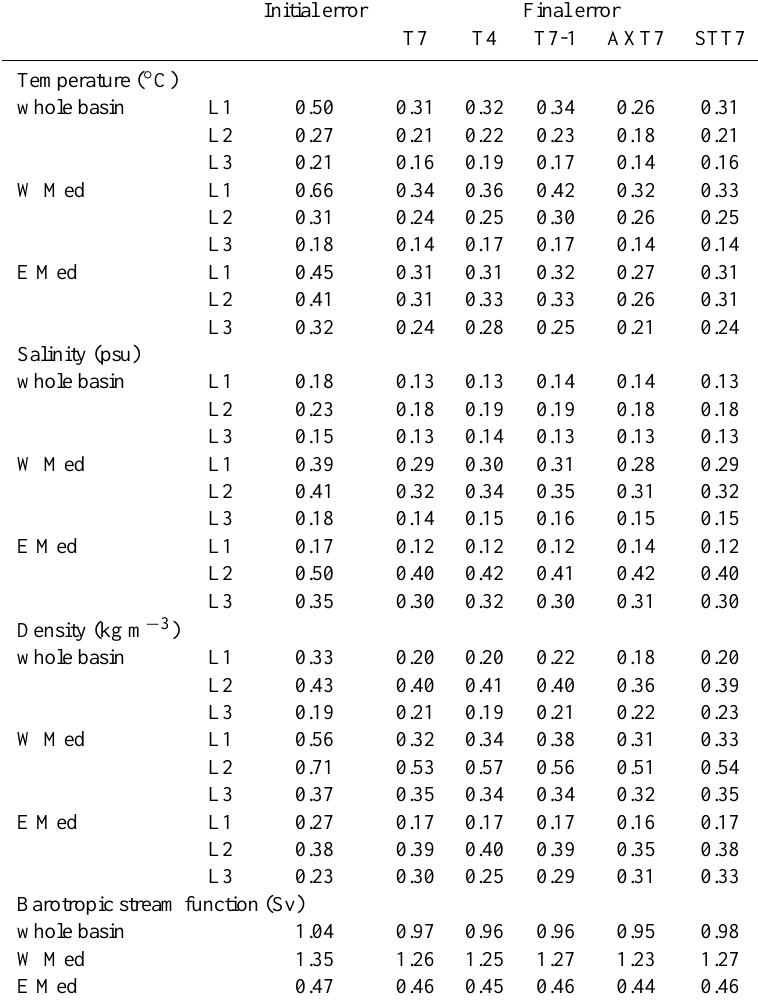
Table 5. Summer OSSEs: Initial and final errors in the assimilation runs relative to the control run for selected sampling strategies (T7, T4, T7-1, AXT7, STT7) arranged by parameter (temperature, salinity, density, barotropic stream function), basin (whole, western, eastern Mediterranean) and layer (L1, L2,